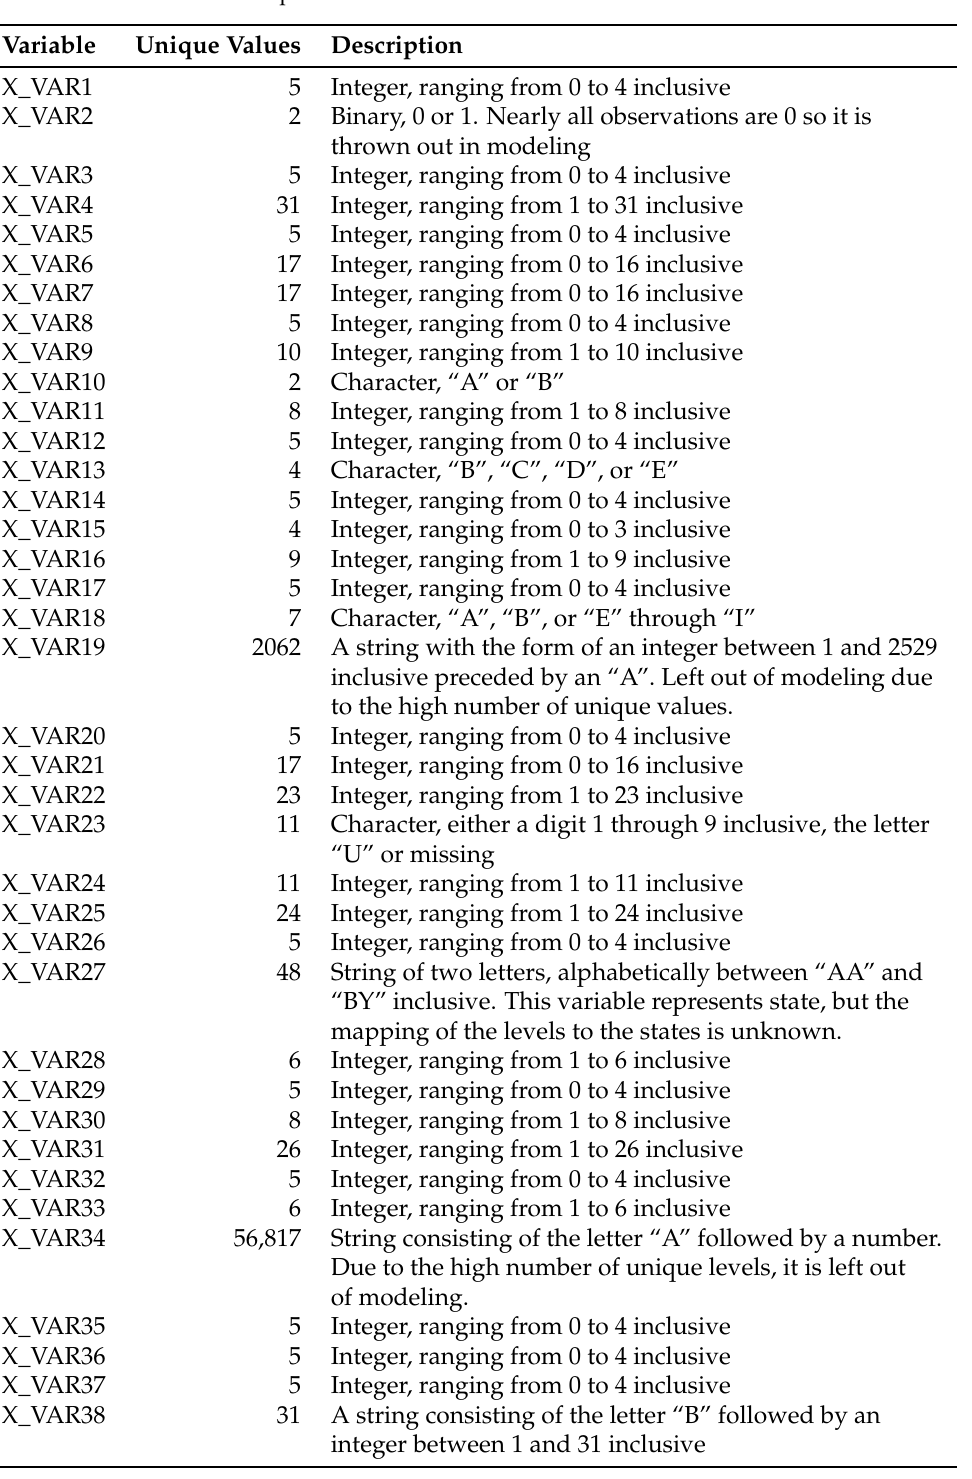
Table 6. Characteristics of the predictor